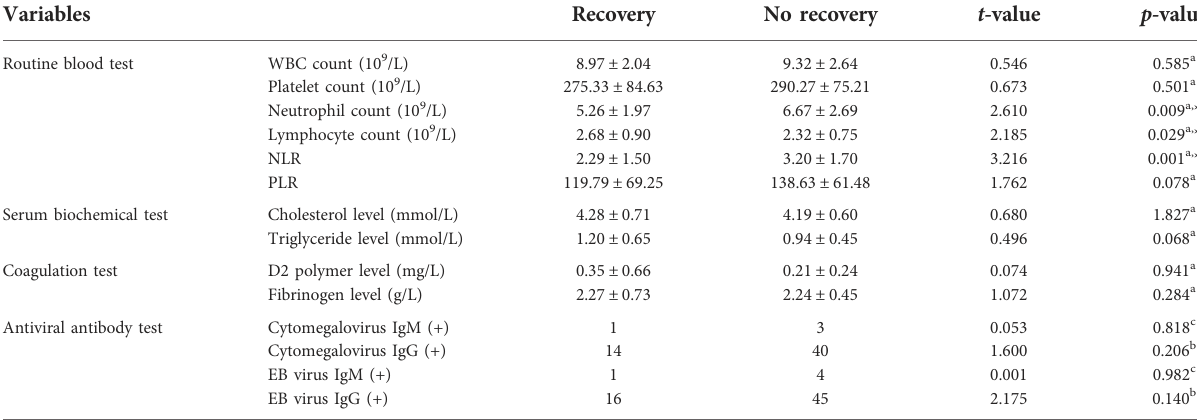
TABLE 4 Comparison of laboratory examination results between patients with and without hearing recovery. Variables